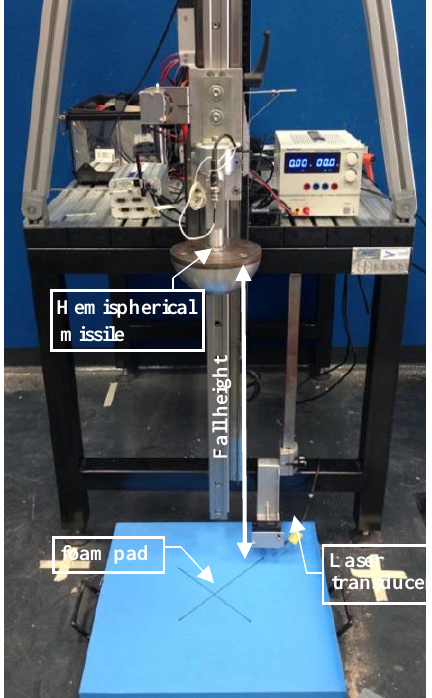
Figure 1. Drop test rig at Fraunhofer JL IDEAS at CESMA, Univ. of Naples Federico II.